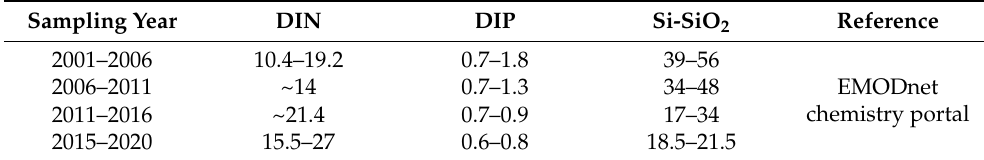
Table 2. Nutrient levels in North Adriatic Sea found in EMODnet chemistry portal ( µ g L − 1